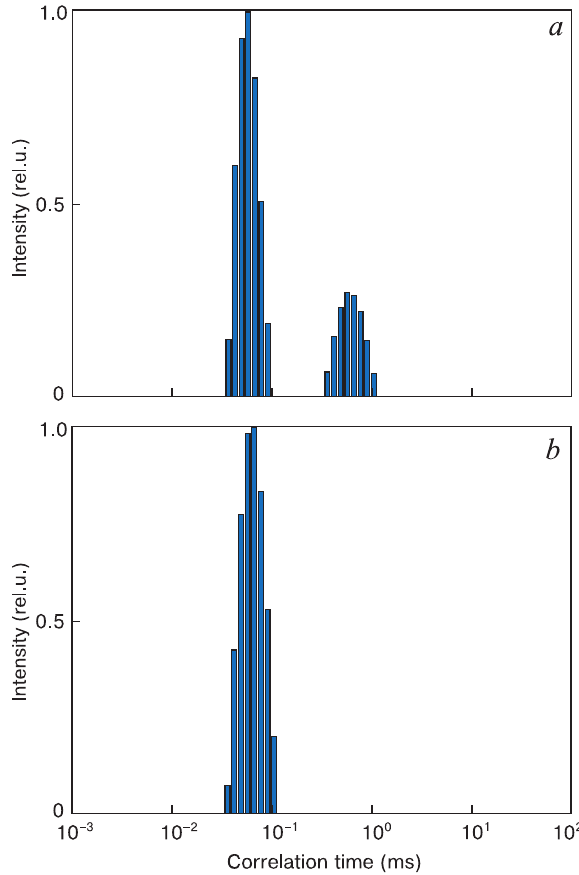
Figure 2. Correlation time distributions for Sample No. 5 for ( a ) VV polarization and ( b ) VH polarization.